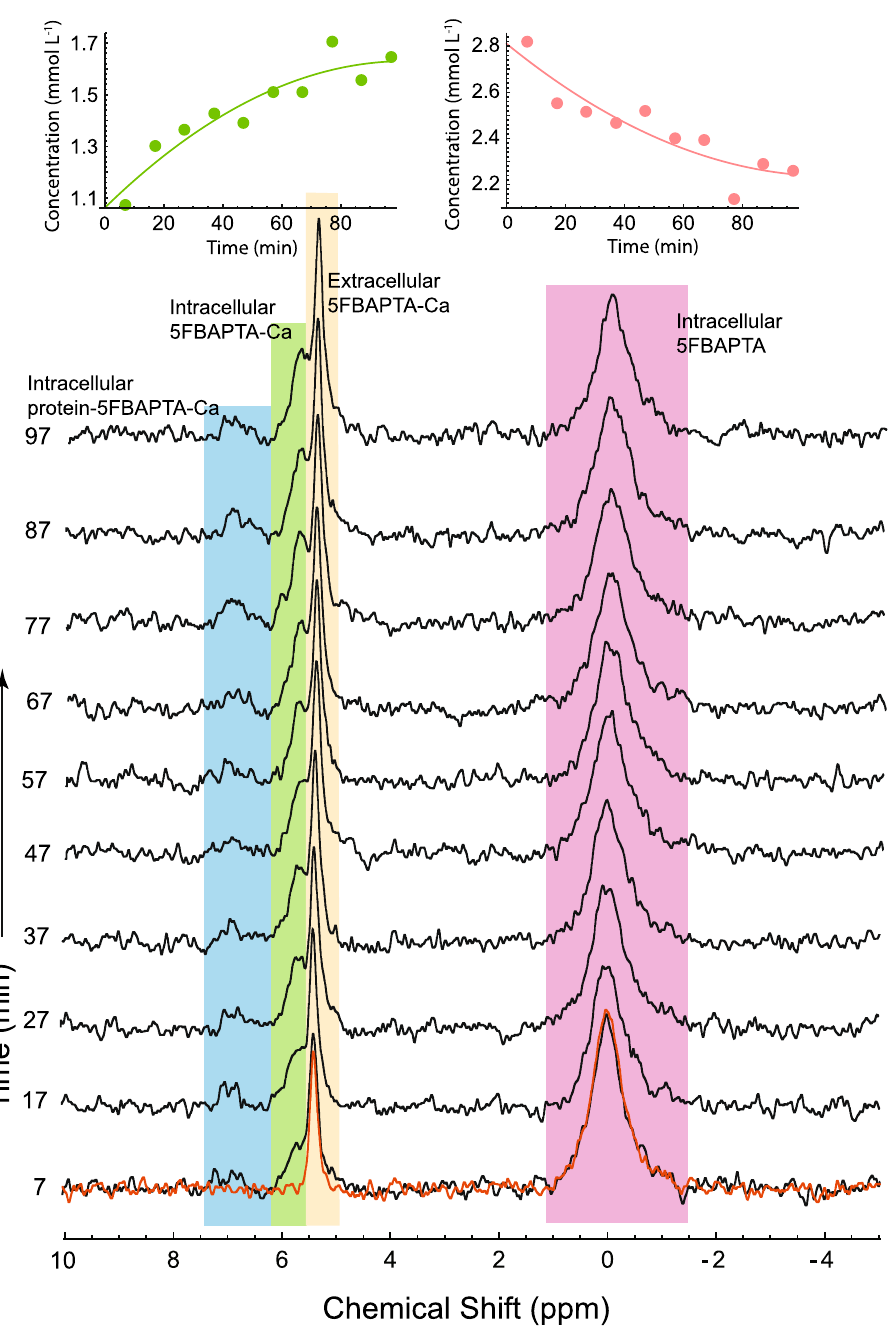
Figure 3. 19 F NMR spectra of RBCs loaded with 5FBAPTA and treated with Yoda1 in the presence of Ca 2+ , at 37 °C. The peak from free 5FBAPTA inside the RBCs (initially 4 mmol [L RBC] −1 ) is highlighted in pink; yellow highlights the peak from the extracellular 5FBAPTA-calcium complex; green, the peak from the intracellular 5FBAPTA-calcium complex; and blue, the peak from the intracellular protein-5FBAPTA-calcium complex. The sample was 0.5 mL RBCs ( Ht = 0.73) in 154 mM NaCl and 10 mM d-glucose. The spectra were recorded every 10 min with NMR settings as for Fig. 1. The superimposed red spectrum at 7 min is from the 6th spectrum of a 1 h time course recorded with the RBCs in the presence of 2.0 µL 1 M CaCl 2 (corresponding to 4.0 mM Ca 2+ concentration averaged over the sample). Then, Yoda1 was added as 1.0 µL of 14 mM in DMSO; this value combined with the knowledge of the Ht value gave a concentration of 38 µmol [L RBC] −1 . Left inset: combined integral of the peak from 5FBAPTA-Ca (green plus yellow). Right inset: integral of intracellular free 5FBAPTA (pink). The fitted equations and their parameter values were (left and right,